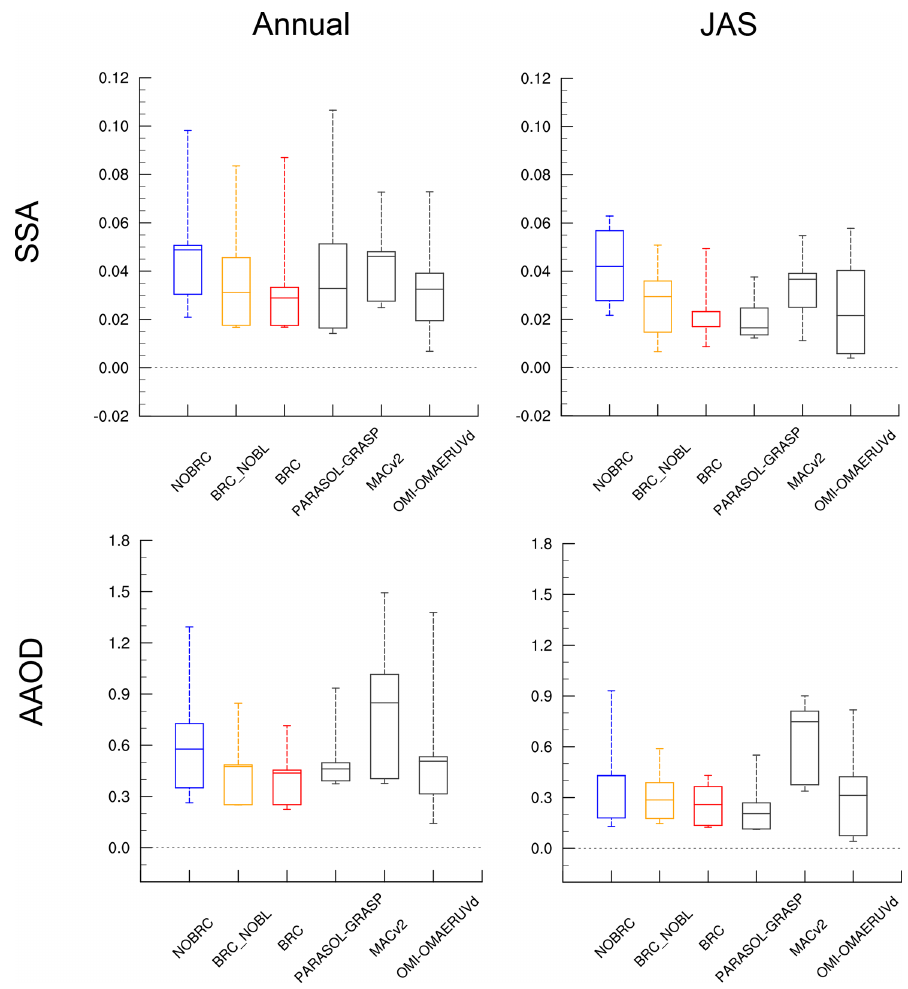
Figure 6. Same as Fig. 5 but for the normalized root mean square error